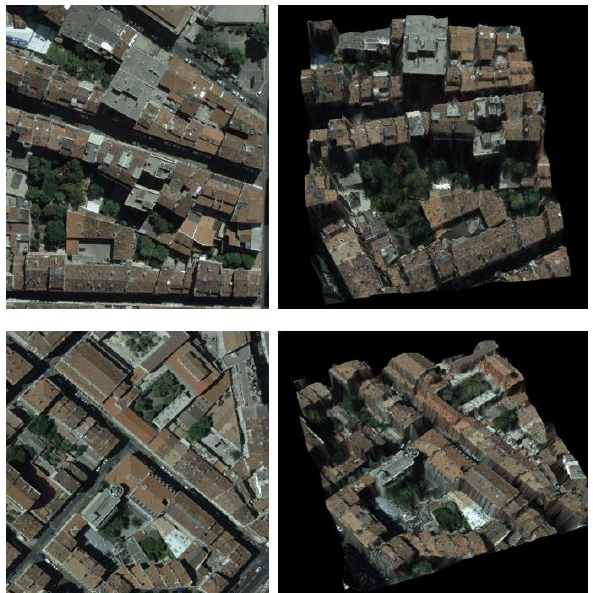
Figure 14. Details of a TIN derived from unfiltered point cloud (right) and corresponding image sections